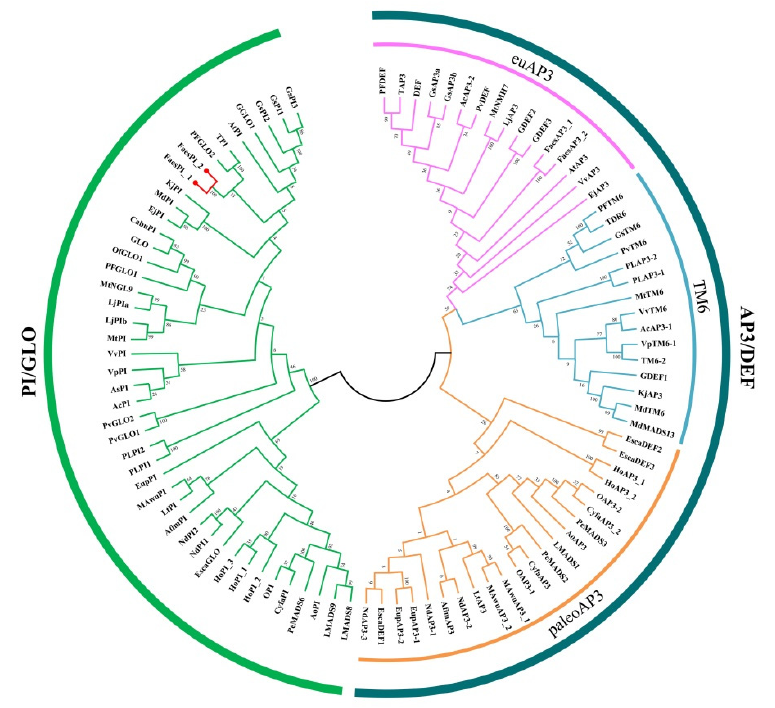
Figure 2. Phylogenetic tree of FaesPI_1 , FaesPI_2 , and other B-class MADS-box proteins from differ- ent species.